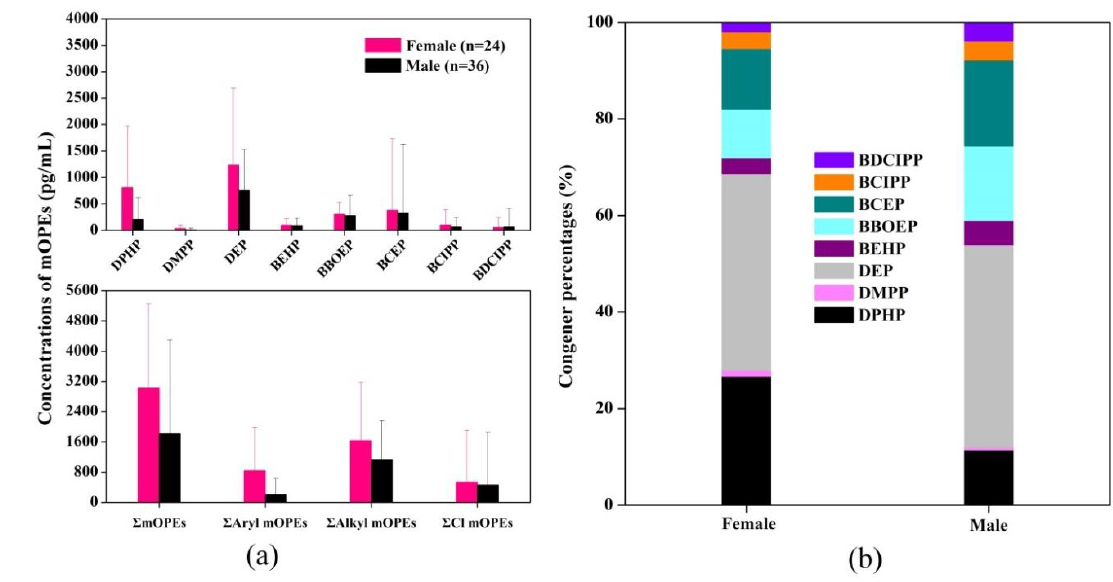
Figure 3. ( a ) Concentrations of mOPEs in male and female urine samples (pg/mL); ( b ) Composition of mOPEs in male and female urine samples (%).